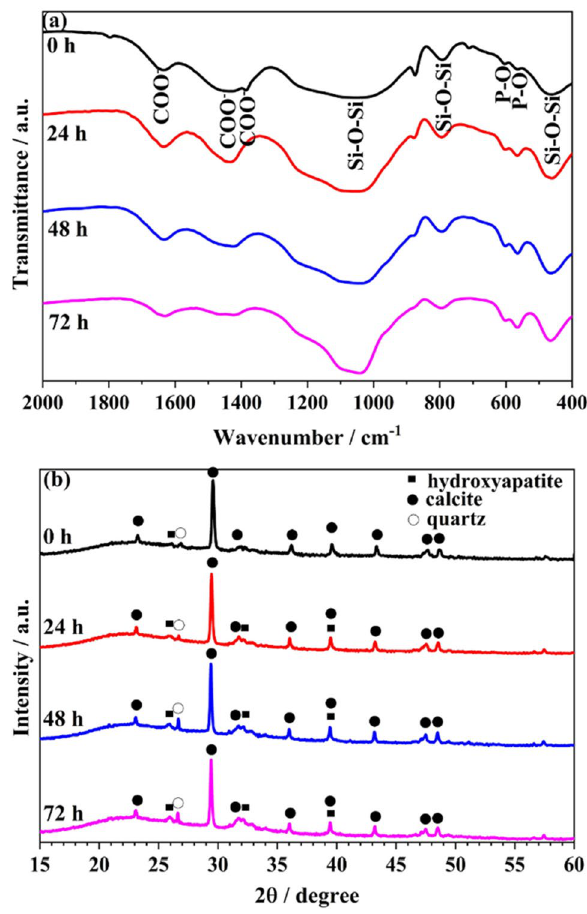
Figure 3. ( a ) FTIR spectra, and ( b ) X-ray diffraction patterns, of BG-Carb composite samples before (0 h), and after immersion in SBF for the different time periods indicated (24 h, 48 h, and 72